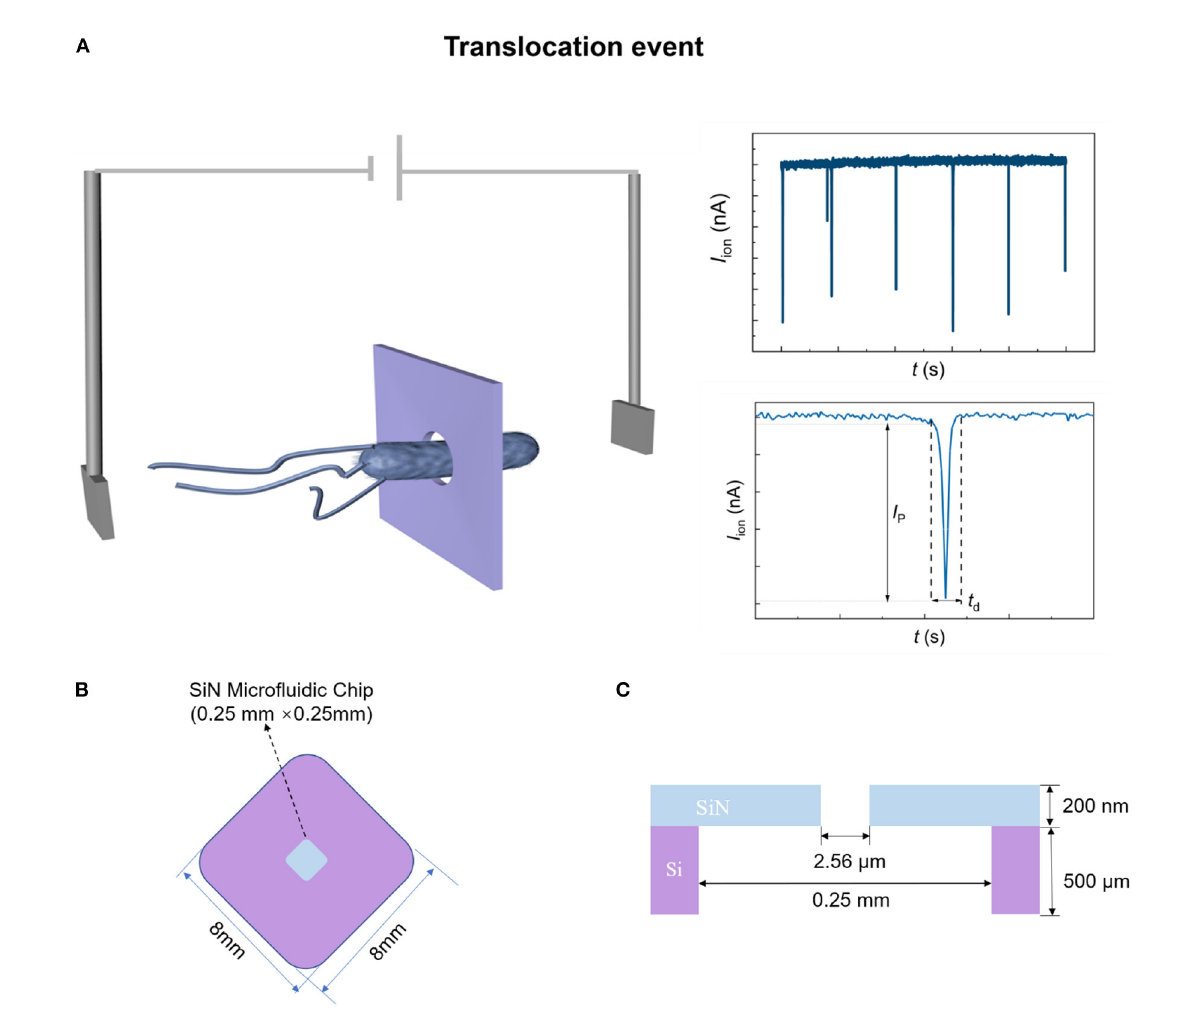
FIGURE1 Schematic diagram of SiN chip sensing system. (A) Schematic diagram of bacterial translocation through a single micropore. (B,C) The top-view (B) and cross-sectional (C) structure diagram of the SiN